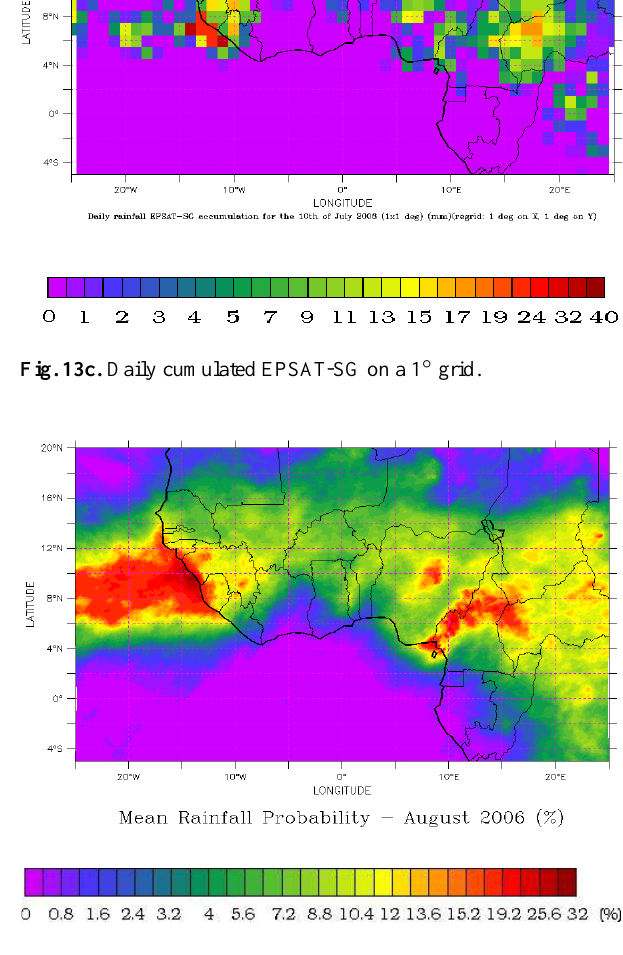
Figure 14.a. EPSAT-SG rainfall probability field for August 2006 Fig. 14a. EPSAT-SG rainfall probability field for August 2006.